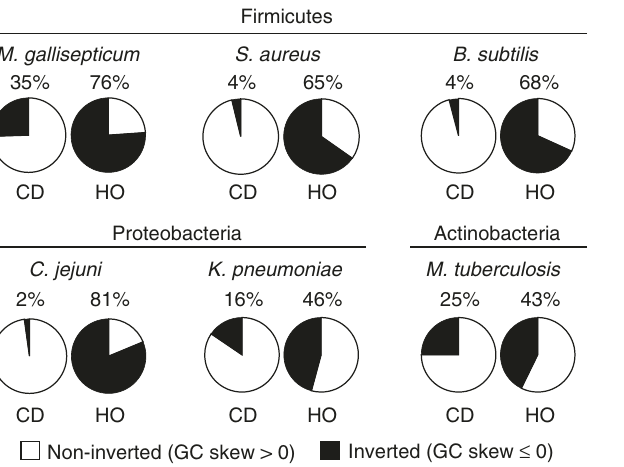
Fig. 3 A large percentage of head-on genes were originally co-directional. The GC skew values of individual genes were binned by their current orientation in the reference genome and again by GC skew value. Positive GC skew values indicate long-term retention in the current orientation. Negative GC skew values indicate that a gene has inverted from the opposite strand/orientation. GC skew values are also presented in the form